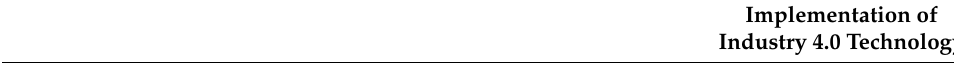
Table 4. Correlation Between Focus on Sustainable Development, the Level of CSR Strategy Imple- mentation and Value Creation in a Sustainable Enterprise—Results for Poland and